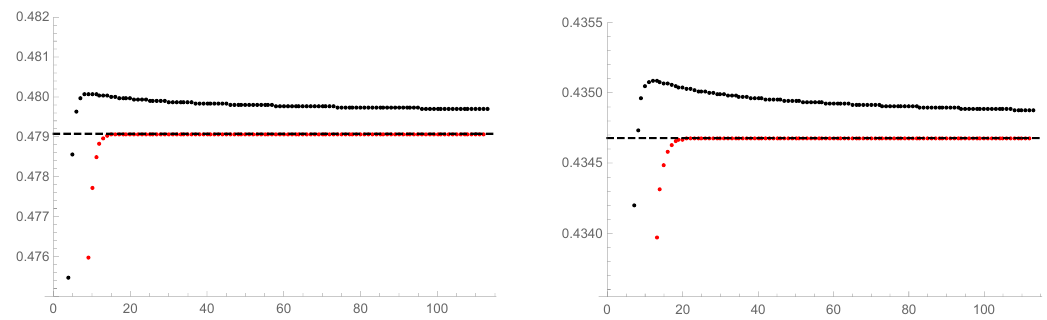
Figure 3 . Plot of the sequence s k in (3.72) for the Gross-Neveu model with N = 7 (left, black) and N = 8 (right, black) as well as their respective second Richardson transforms (red). The dashed line is the predicted value 2 2∆ S 0 / (2 π ) .